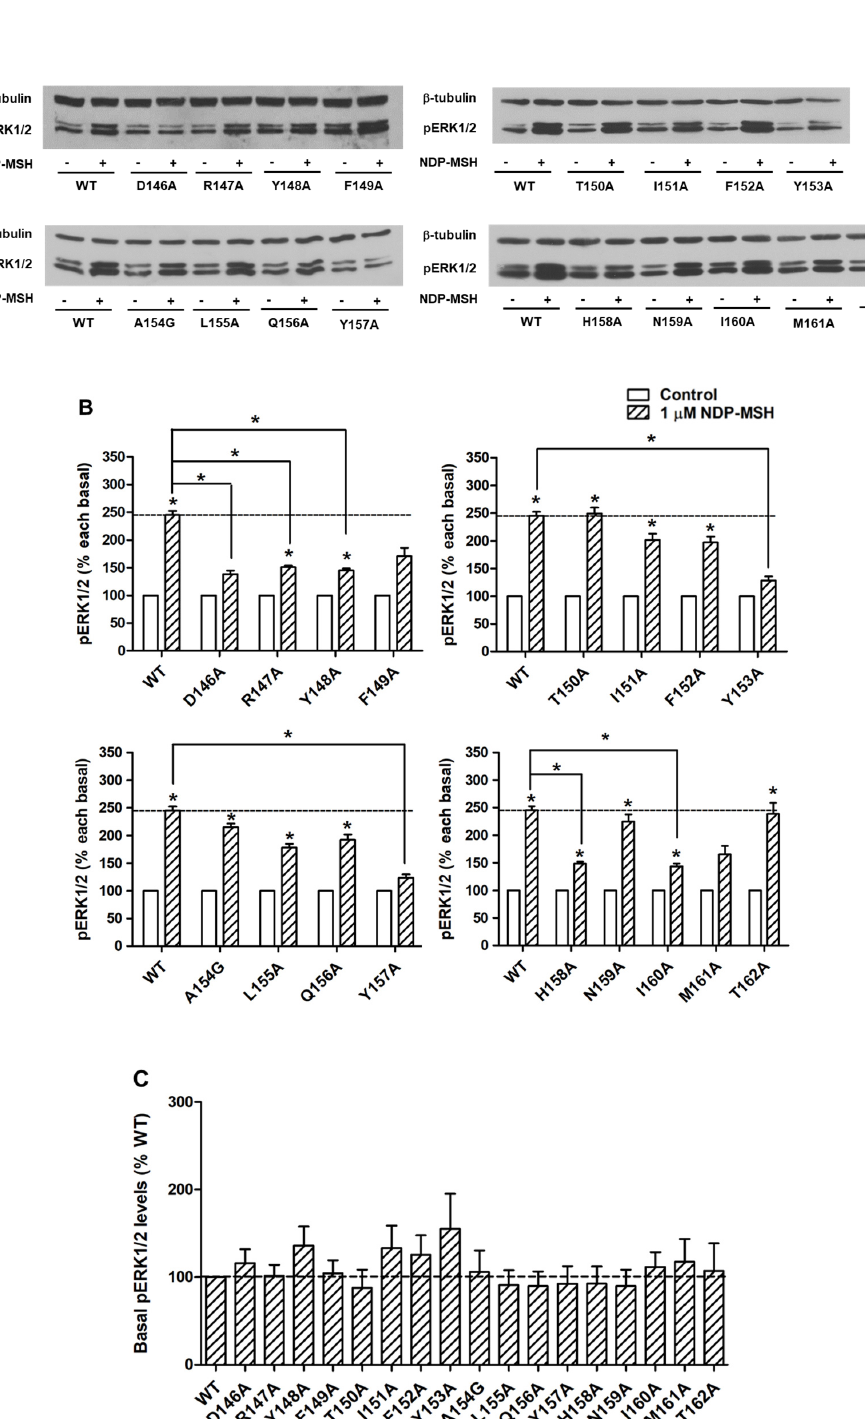
Figure 6. The ERK1 / 2 signaling properties of WT and mutant MC4Rs. HEK293T cells were transiently transfected with WT and mutant MC4Rs and pERK1 / 2 levels were measured by western blot without or with stimulation of 10 − 6 M NDP-MSH for 5 min. ( A ) Western blot analysis was performed using antibody against pERK1 / 2 and β -tubulin as control. ( B ) Data of the pERK1 / 2 levels of the WT and mutant MC4Rs after NDP-MSH stimulation are expressed as % of each basal from at least five independent experiments. * indicates significant di ff erence from basal pERK1 / 2 level or from the stimulation of the WT MC4R ( p < 0.05). ( C ) Data of the basal pERK1 / 2 levels are mean ± S.E.M. of at least five independent